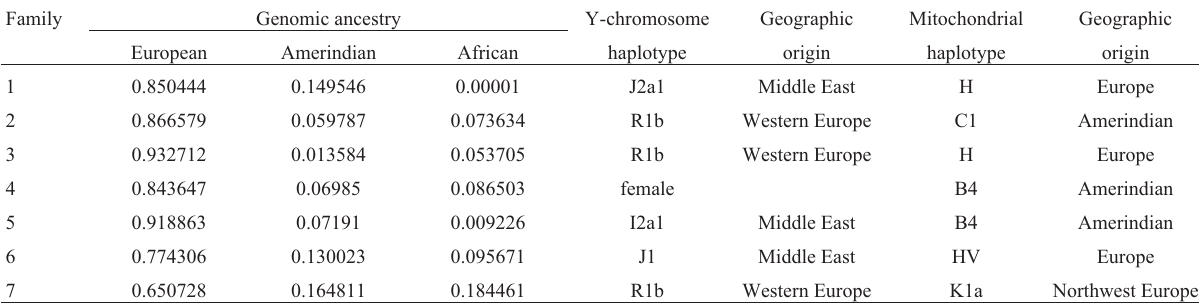
Table 2 - Summary of genomic ancestry analysis and Y-chromosome and mitochondrial DNA